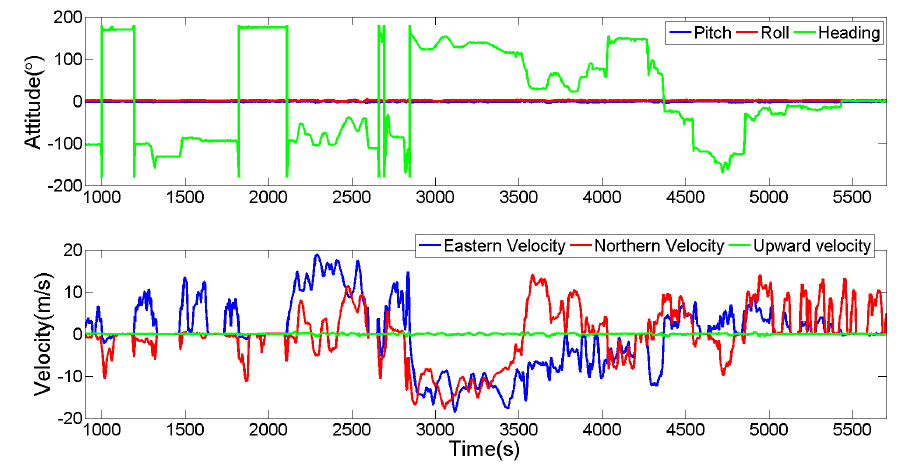
Figure 6. The vehicle’s dynamic characteristics during the experiment.